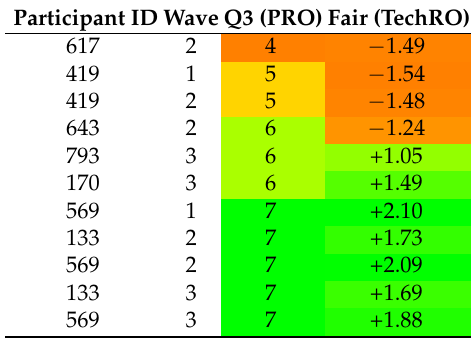
Color coding: from orange (lower values) to yellow to green (higher